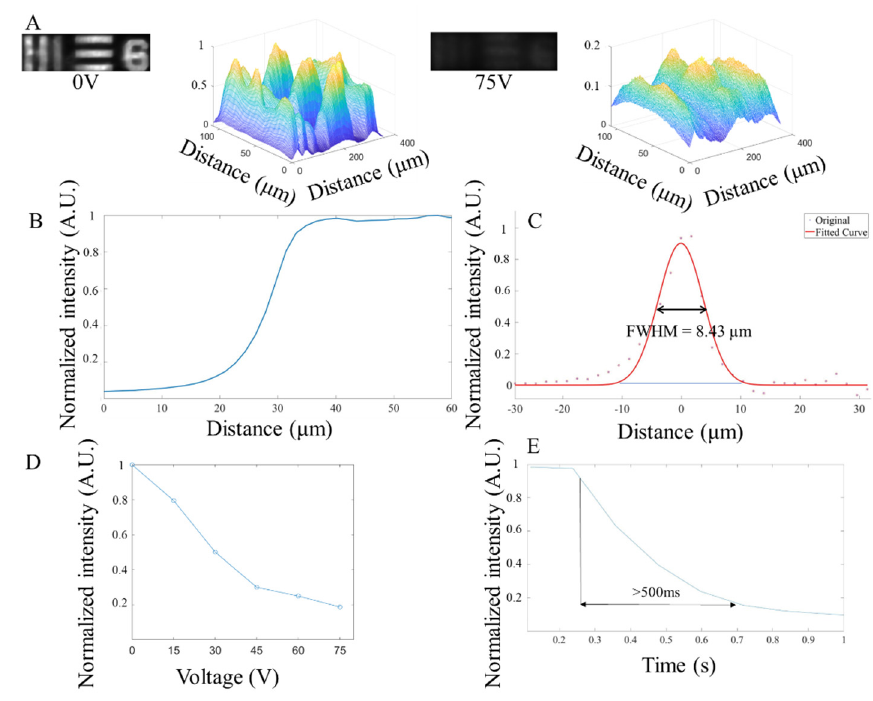
Figure 5. The NLC performance of the liquid crystal under the bright field condition. ( A ). The mi- croscope image through the NLC (1951 USAF resolution test chart) and the light intensity distribu- tion color map at 0 V ( left ) and 75 V ( right ). ( B ). The ESF of the NLC. ( C ). Estimation of the NLC’s LSF and Gaussian fitting curve at 0 V. ( D ). Average measurement of light intensity changes under different voltages. ( E ). Response time (change from 90% to 10% of the normalized light intensity step height) of the NLC under 75 V.